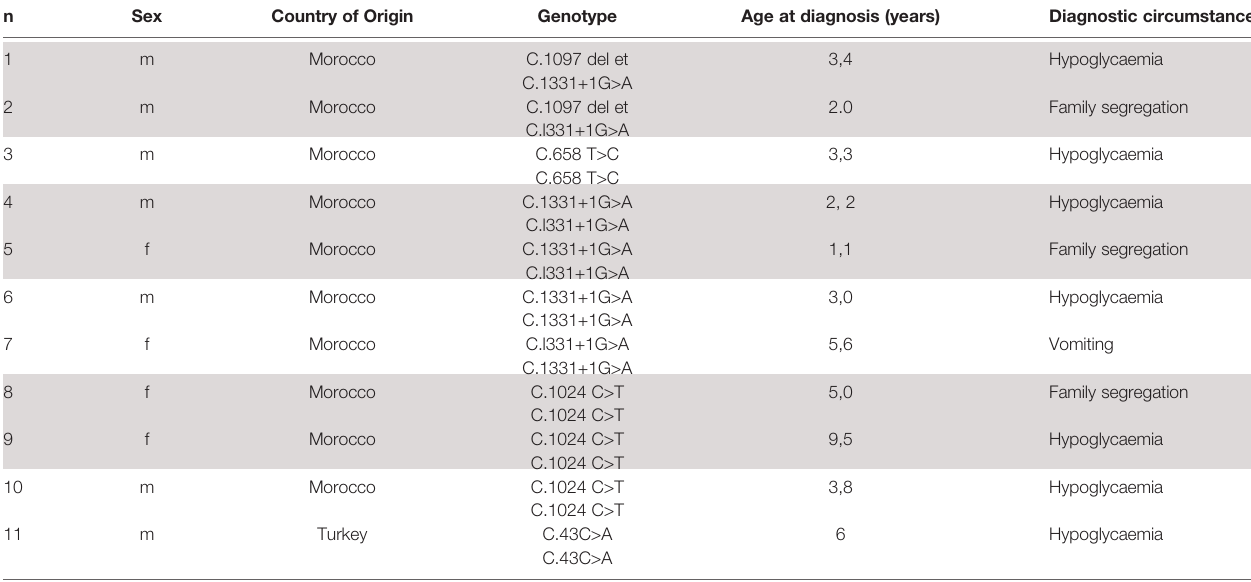
TABLE 1 | Characteristics of the study series of patients with Triple A syndrome.